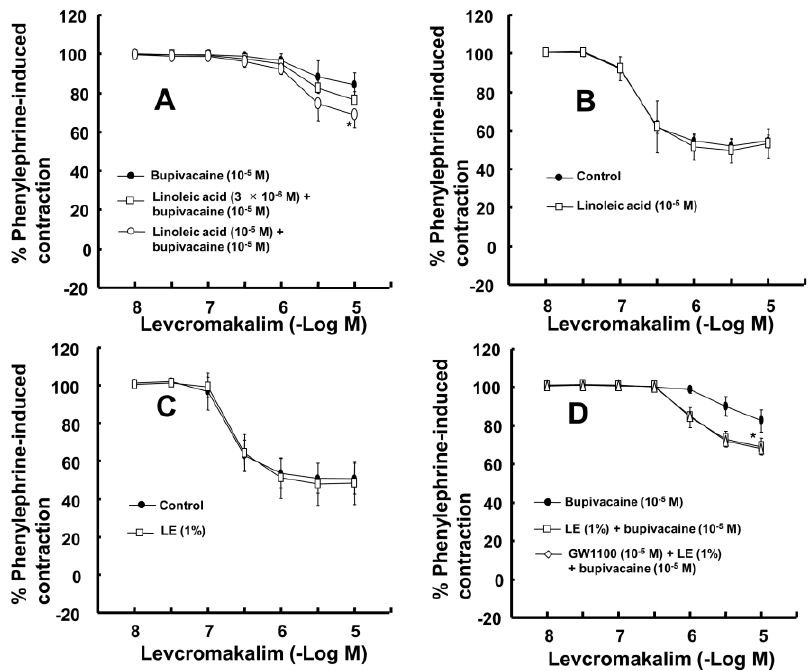
Figure 2. ( A ): Effect of linoleic acid on the toxic dose of bupivacaine-mediated reduction of levcromakalim-evoked vasodilation in isolated rat aortas without endothelium. Data ( n = 9) are expressed as the mean ± SD and shown as a percentage of the contraction evoked by phenylephrine. Data were analyzed by a Kruskal-Wallis test with Dunn’s multiple comparison test. n indicates the number of isolated rat aortas. Maximal vasodilation induced by levcromakalim (10 −5 M): * p < 0.001 versus bupivacaine. ( B ): Effect of linoleic acid alone on the levcromakalim-evoked vasodilation in isolated rat aortas without endothelium. Data ( n = 8) are expressed as the mean ± SD and shown as a percentage of the contraction evoked by phenylephrine. n indicates the number of isolated rat aortas. ( C , D ): Effect of lipid emulsion (LE) (( C ), n = 10) alone on the levcromakalim-evoked vasodilation in isolated rat aortas without endothelium and the effects of LE (( D ), n = 10) alone and combined treatment ( n = 10) with GW1100 and LE on the toxic dose of bupivacaine-mediated reduction of levcromakalim-evoked vasodilation in isolated rat aortas without endothelium. Data are expressed as the mean ± SD and shown as a percentage of the contraction evoked by phenylephrine. Data were analyzed by one-way ANOVA followed by Bonferroni’s multiple comparison test or unpaired Student’s t -test. n indicates the number of isolated rat aortas. Maximal vasodilation induced by levcromakalim (10 −5 M): * p < 0.001 versus bupivacaine alone.